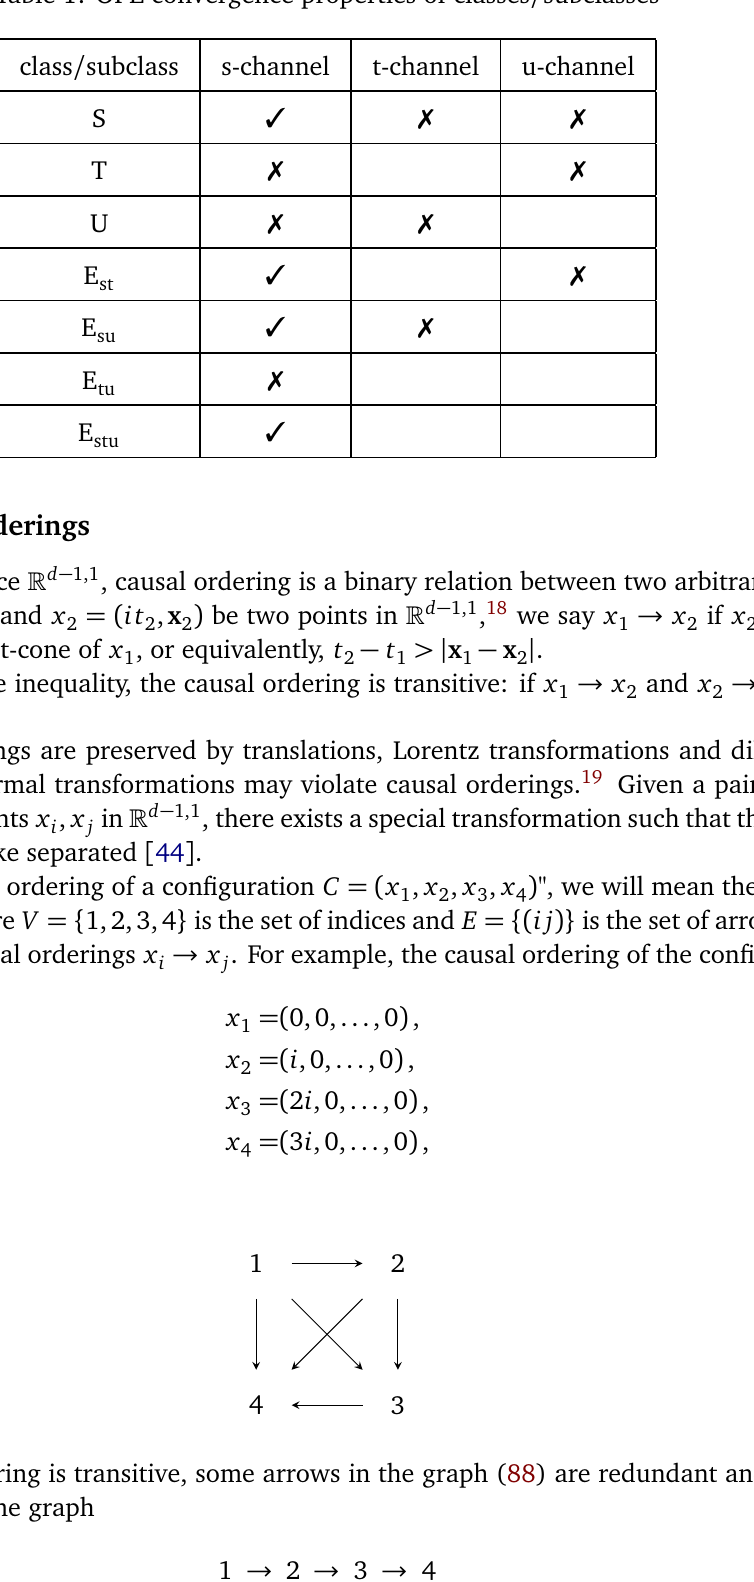
Table 1: OPE convergence properties of classes /